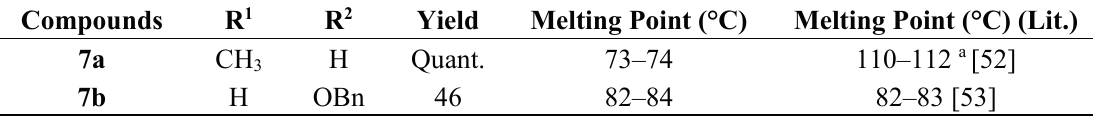
Table 6. Yield and melting point data of the compounds 7a , b